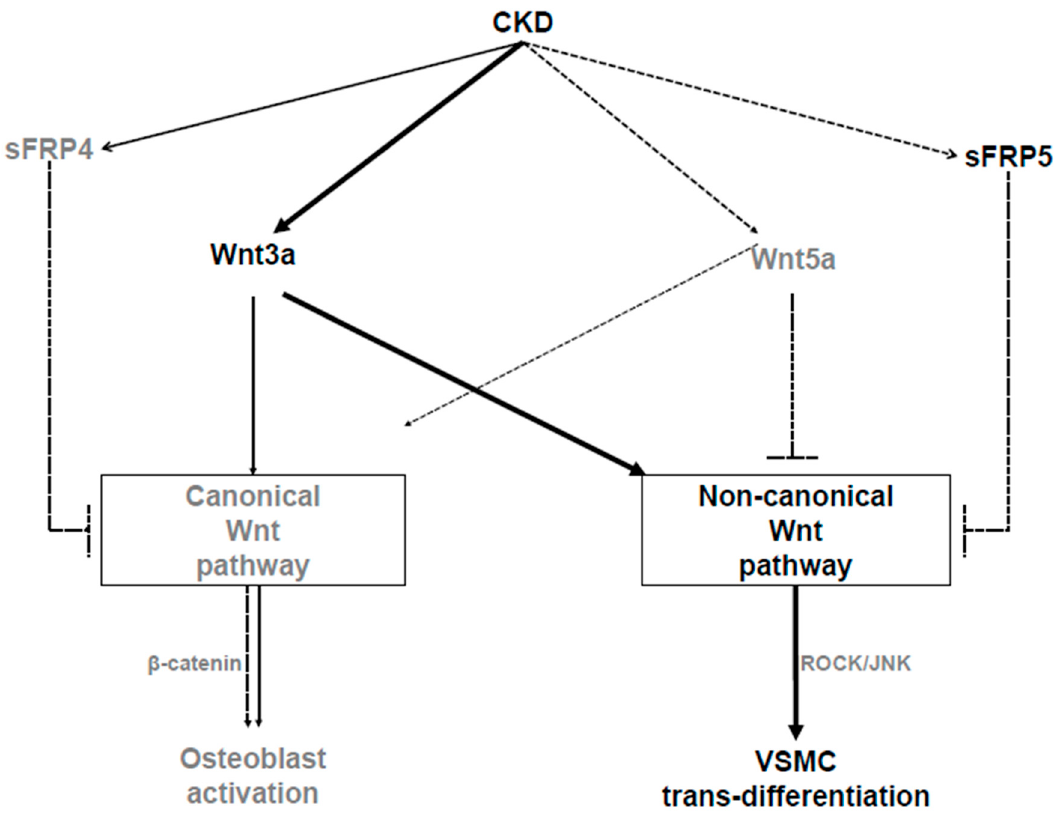
Figure 8. Schematic diagram showing the pathways involved in the pathogenesis of vascular calcification (VC) in chronic kidney disease (CKD). As CKD progresses, secreted frizzled-related protein 5 (sFRP5) and Wnt5a levels decrease, while Wnt3a levels increase. Wnt3a can activate the canonical or noncanonical Wnt signaling pathway. With regard to the pathogenesis of VC, Wnt3a activates noncanonical (ROCK/JNK) Wnt signaling, which leads to the trans-differentiation of vascular smooth muscle cells (VSMCs) into osteoblast-like cells. sFRP5 inhibits Wnt3a-mediated activation of the noncanonical Wnt signaling pathway, leading to the attenuation of the osteoblastic trans-differentiation of VSMCs. Wnt5a inhibits canonical Wnt signaling, which leads to the suppression of osteoblast activation following bone loss in CKD. The solid arrows indicate activation, the dashed lines with blocked ends indicate inhibition, and the dashed arrows indicate reductions in the CKD environment.